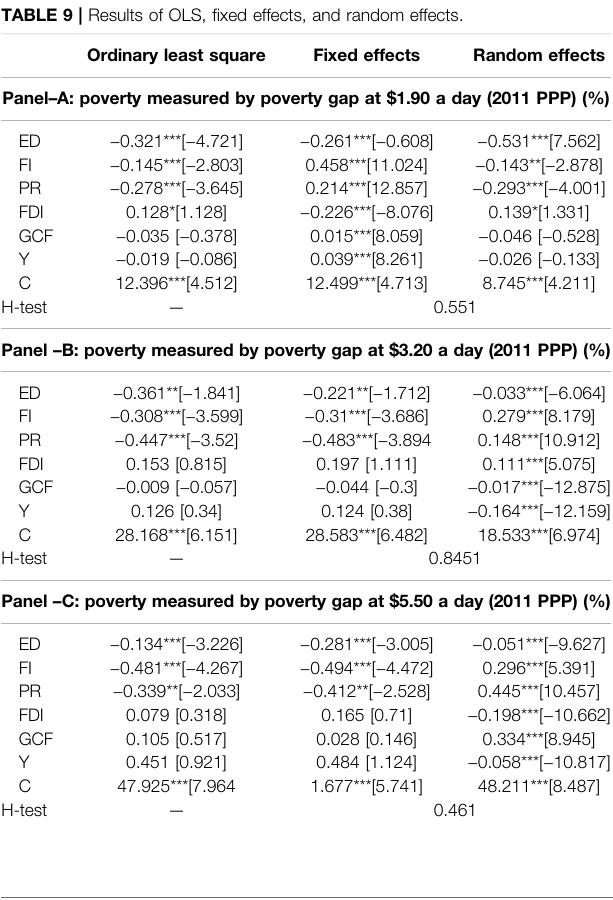
Panel – B: Error correction-based cointegration test